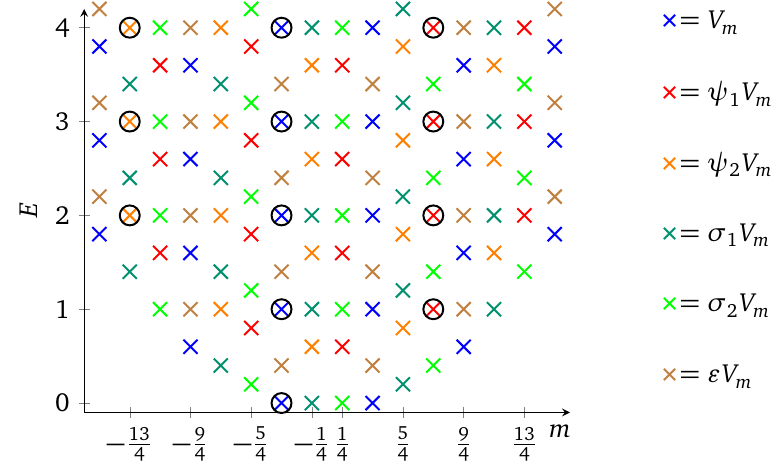
model. The indicated 3